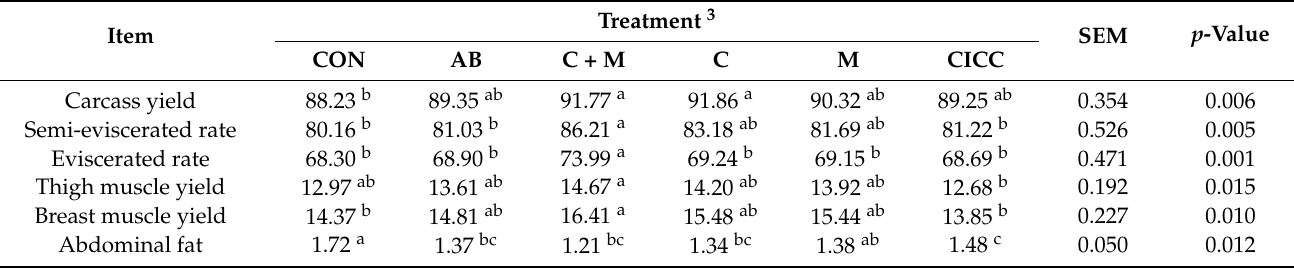
Table 2. Effects of Bacillus amyloliquefaciens LFB112 on carcass characteristics of broilers at 39 days of age (%) 1,2 .